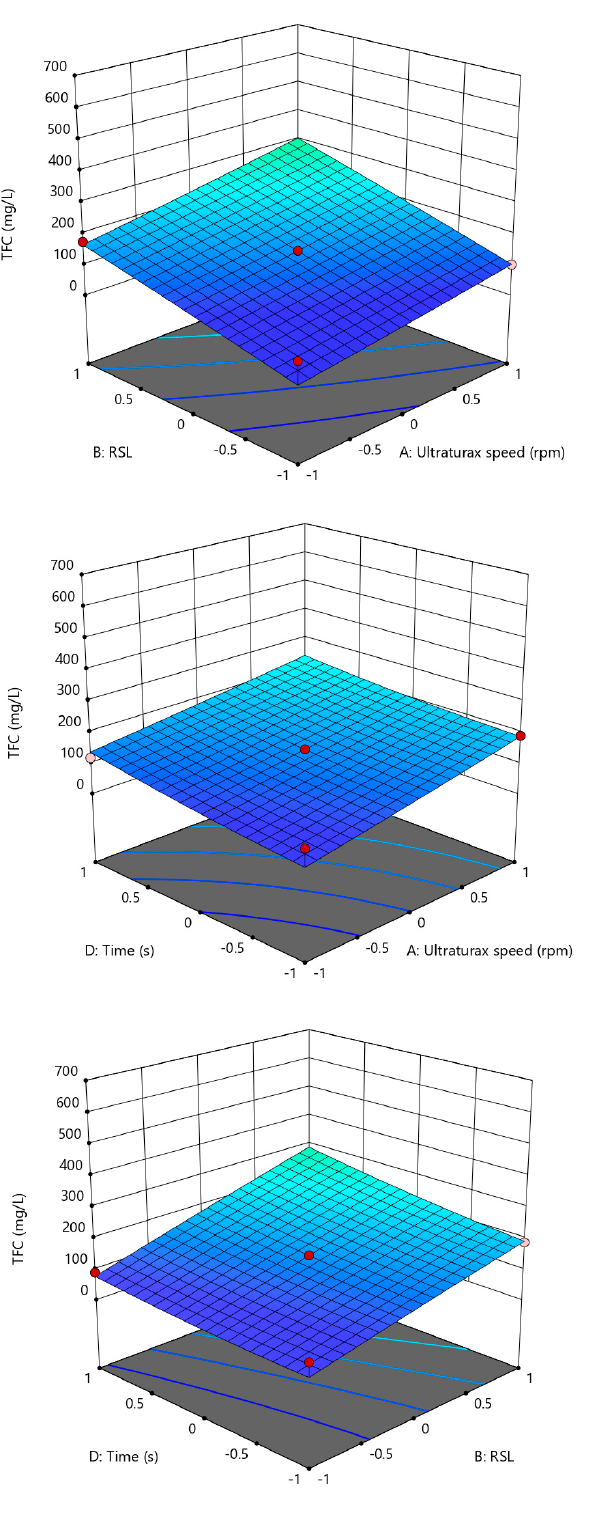
Figure 3. 3D evolution of TFC according to the Box–Benhken design. − 1 the low value of the parameter, +1 the highest value of the parameter according to data from Table 1